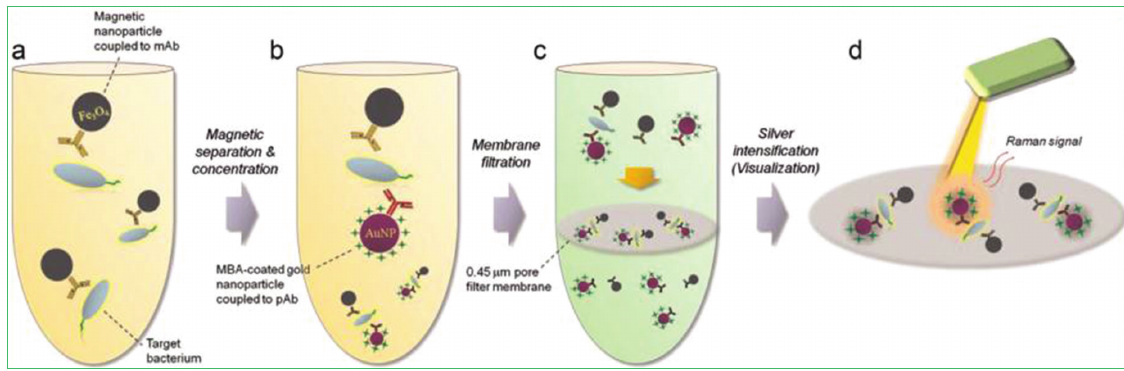
Figure 4: Schematic of the proposed membrane filter-assisted SERS for rapid detection of E. coli O157:H7 in ground beef. Reproduced with permission from Ref. [41]. Copyright 2015